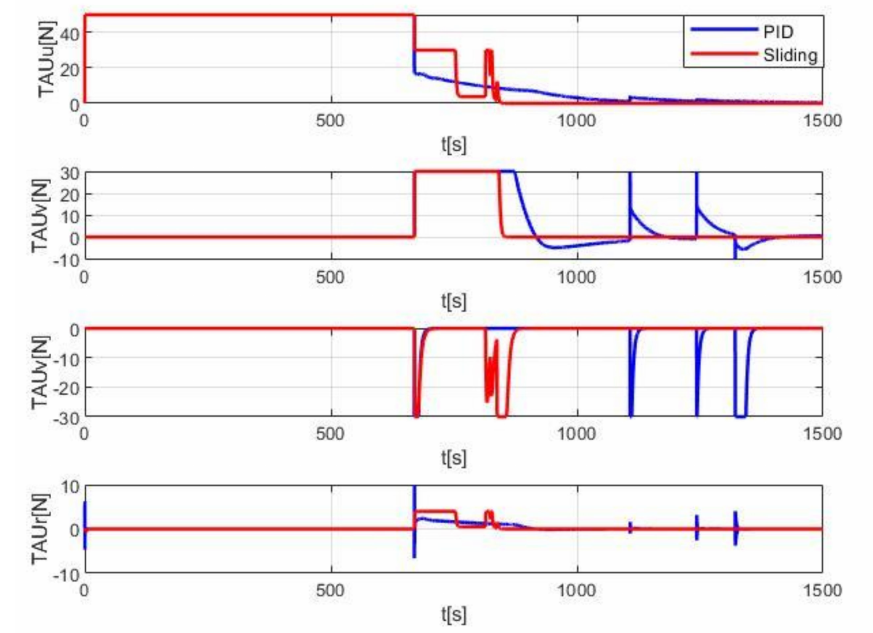
Figure 13. Time history of input force to control the